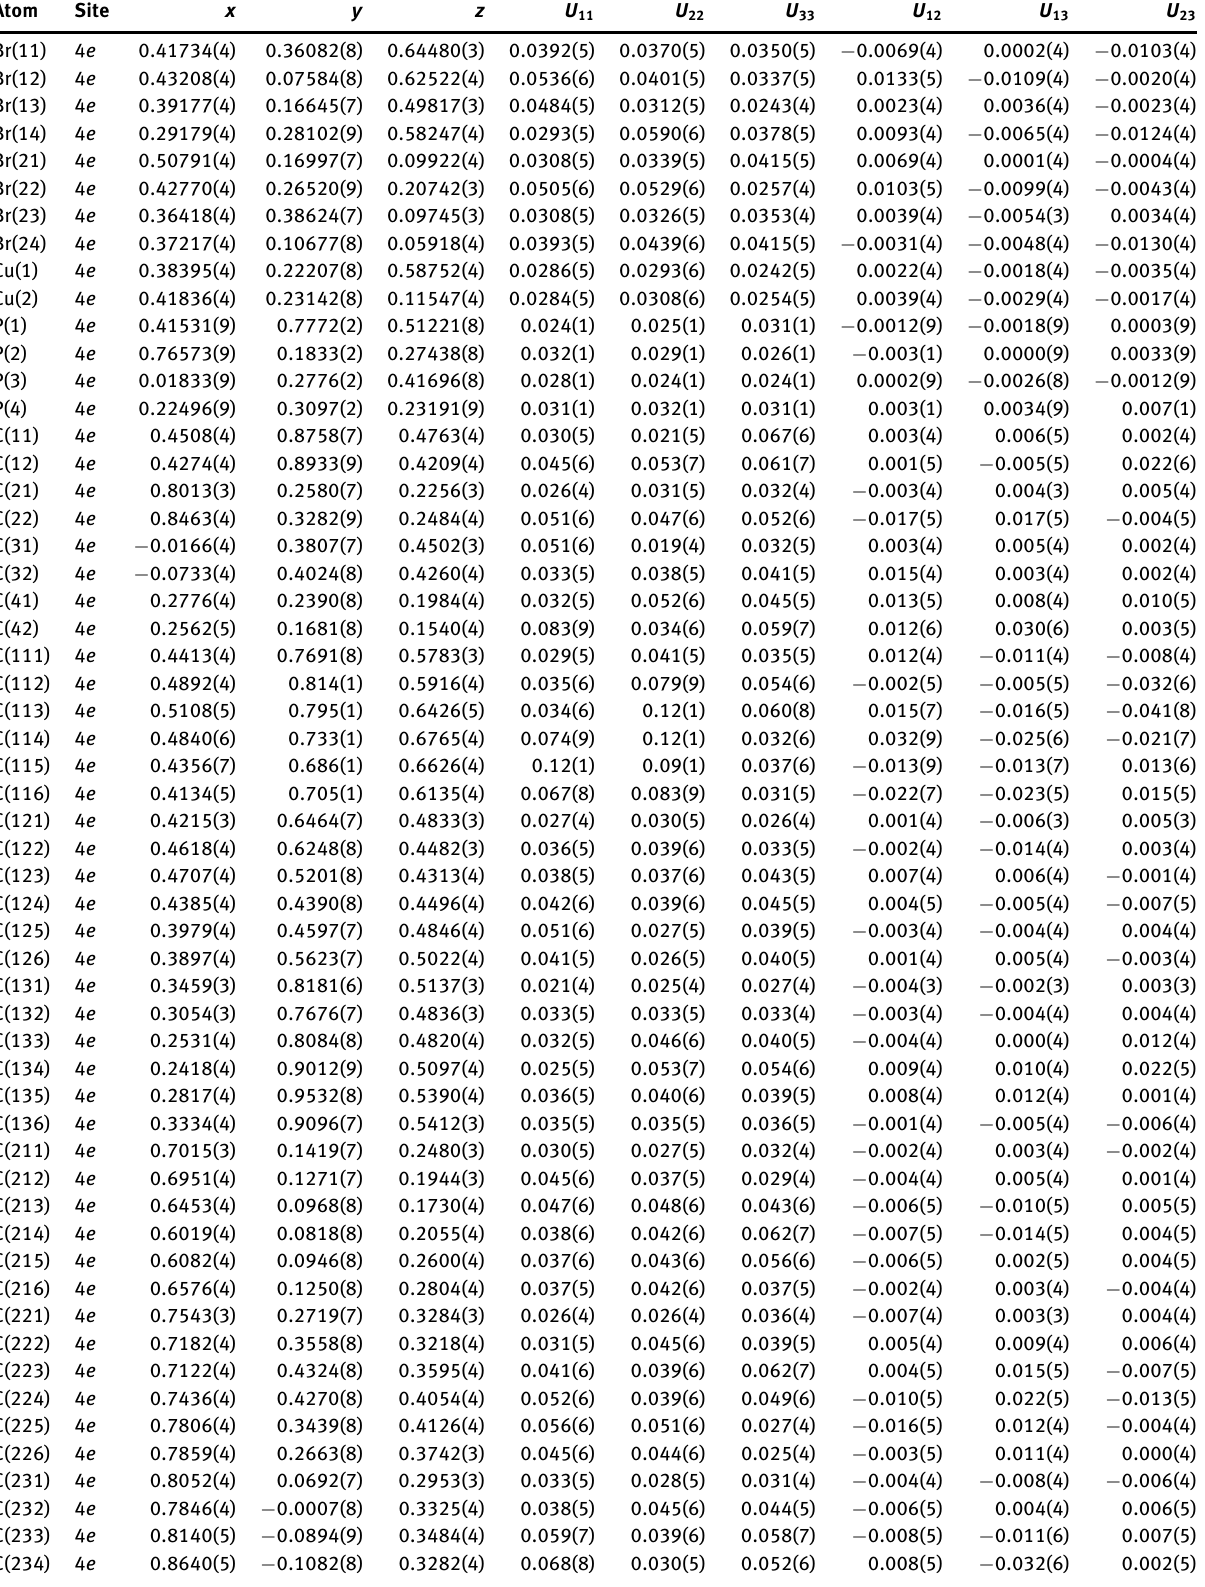
Table 3: Fractional atomic coordinates and atomic displacement parameters (Å 2